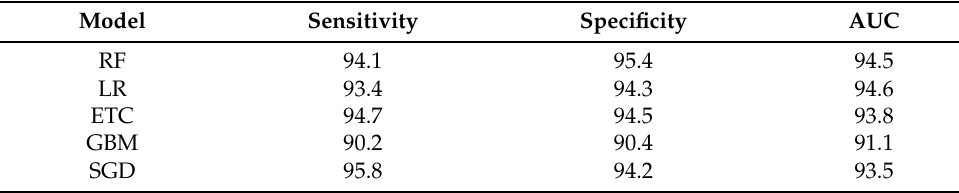
Table 7. Performance of models regarding combined